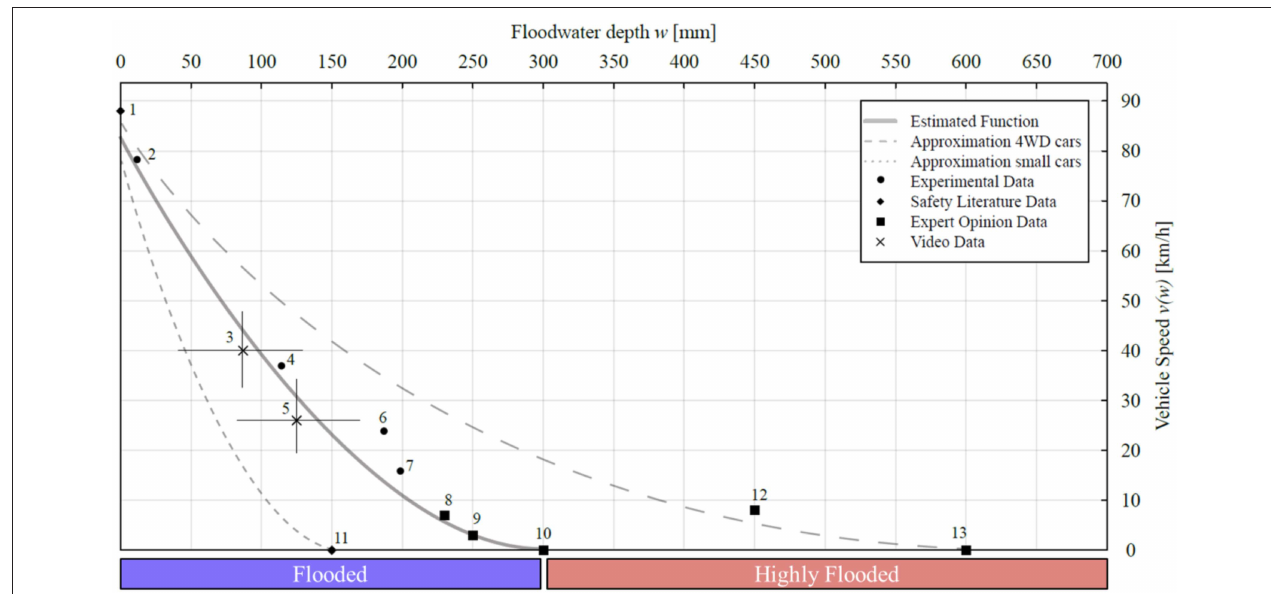
FIGURE 4 | Modeled relationship between flood depth and vehicle speed. Estimated function was used to determine extent of Highly Flooded zones for routing. Figure adapted from Pregnolato et al.